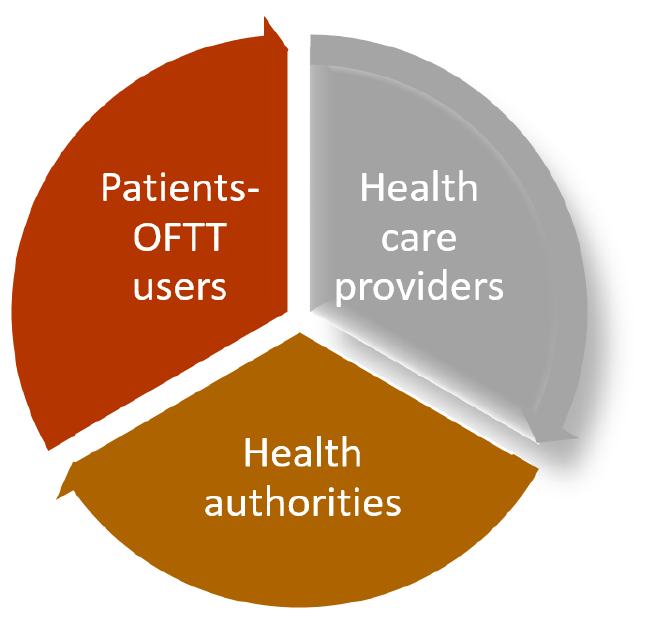
Figure 1. Stakeholders. Figure 1.